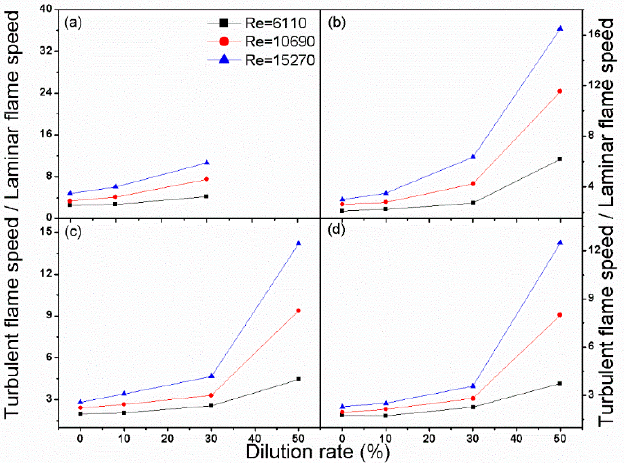
Figure 16. Trend in the ratio of the turbulent flame velocity to the laminar flame speed of the same syngas with different nitrogen dilution rates under different hydrogen proportions and exit Reynolds numbers: ( a ) 5%; ( b ) 25%; ( c ) 50%; ( d ) 75% hydrogen volumetric proportion.